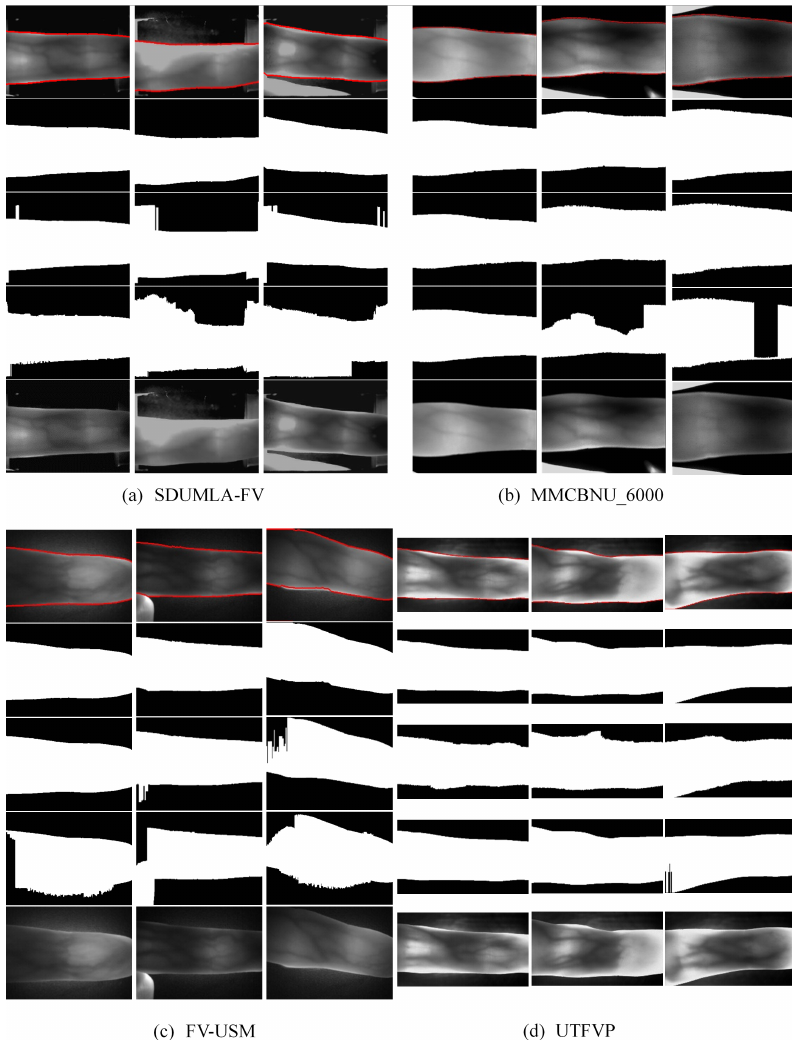
Figure 8. Comparisons of different finger region segmentation methods. For each dataset, first row: visualization of the results of the proposed method; second row: results of the proposed method; third row: results of the first method; fourth row: results of the second method; fifth row: the original